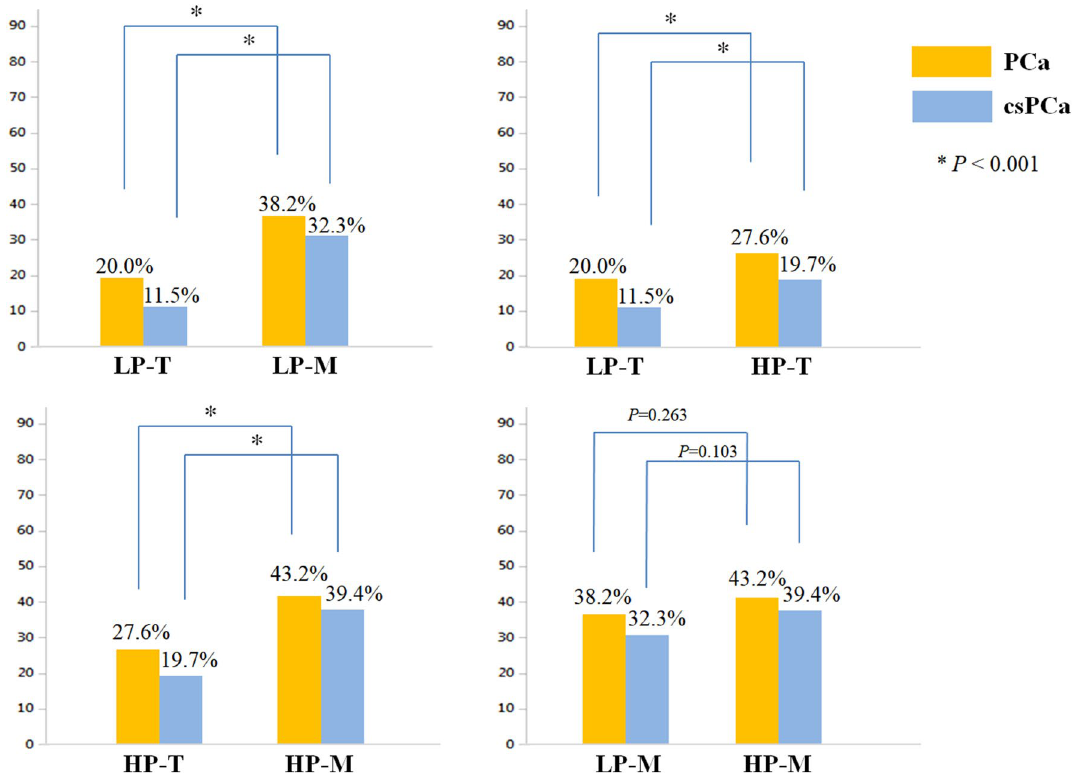
Figure 2. Detection rates of prostate cancer and clinically significant prostate cancer in each group. TRUS-Bx Transrectal ultrasound-guided biopsy, MRI-TBx Magnetic resonance imaging-targeted biopsy. Groups: LP-T (men with PSA 2.5–4.0 ng/mL who underwent TRUS-Bx); LP-M (men with PSA 2.5–4.0 ng/mL who underwent MRI-TBx); HP-T (men with PSA 4.0–10.0 ng/mL who underwent TRUS-Bx); HP-M (men with PSA 4.0–10.0 ng/mL who underwent